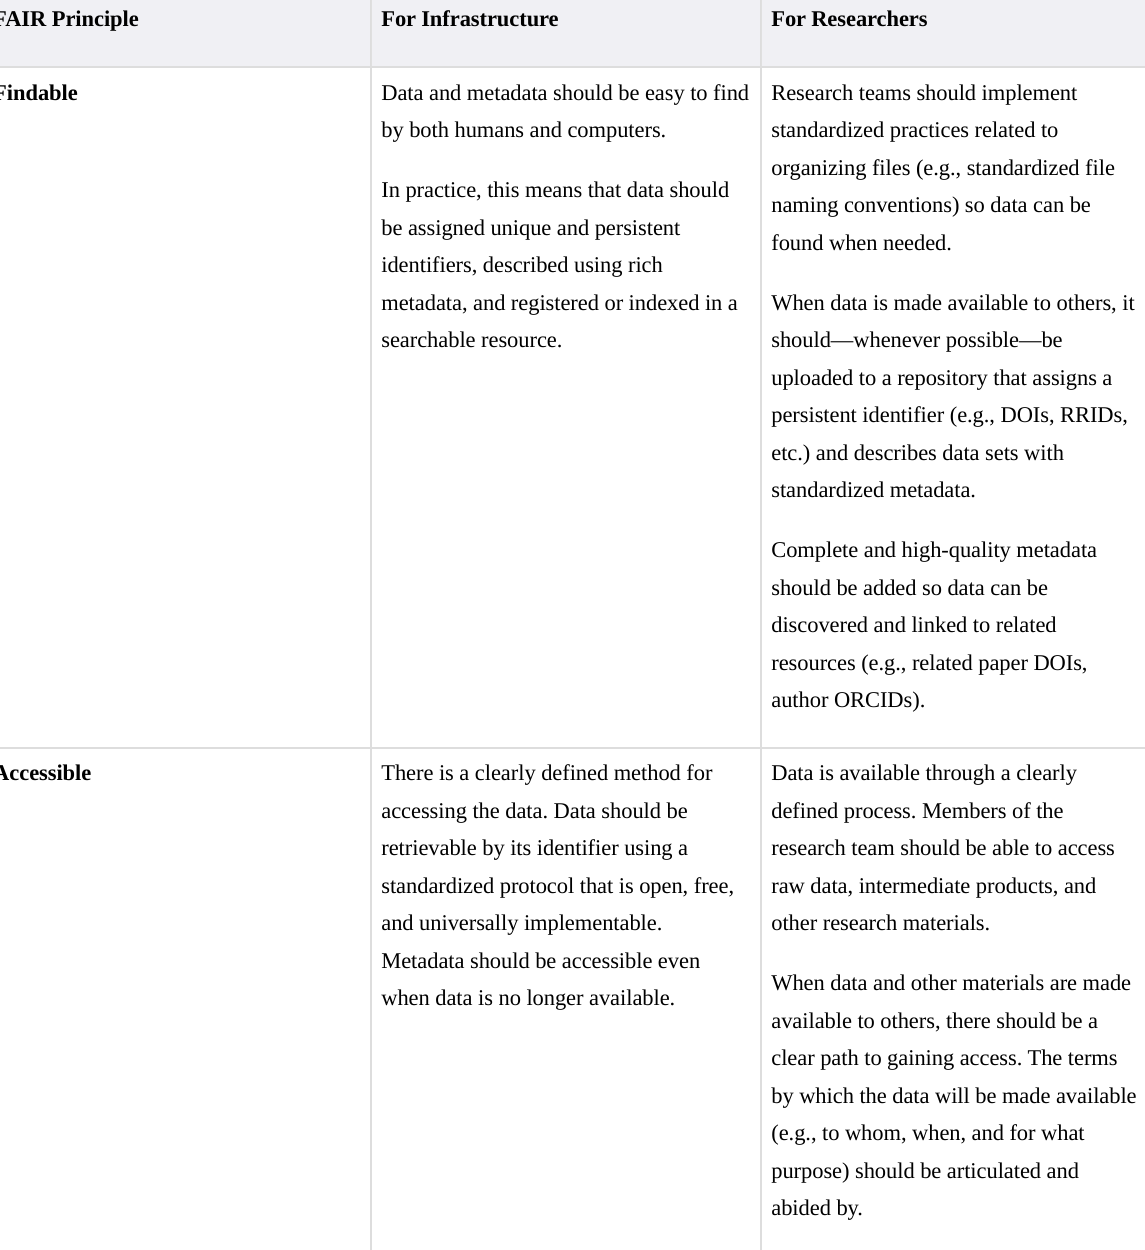
Table 2: Extension of the FAIR guiding principles FAIR